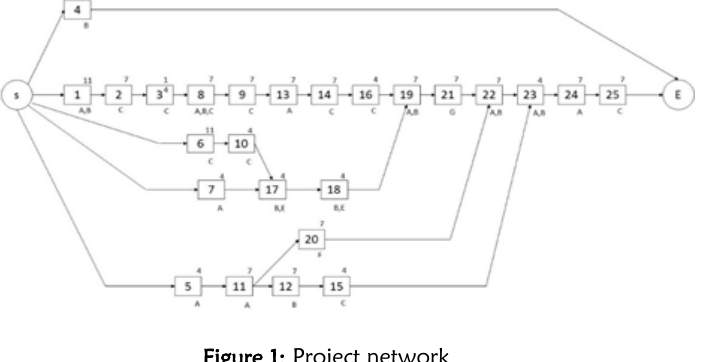
Figure 1: Project